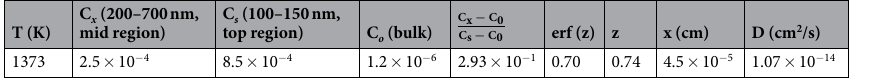
Table 2. Diffusion coefficient calculation for CVT samples that were oxygen annealed at 1100 °C for 24 hours. Diffusion distance, x = 4.5 × 10 − 5 cm. Where, C x , C s and C o values were calculated using the percentage ratio of the zinc vacancy concentration in their respective region to the atomic density (8.3 × 10 22 cm − 3 ). From Fick’s 2 nd